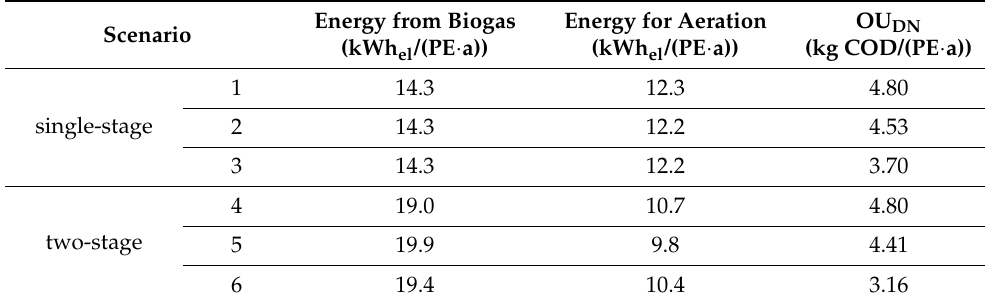
Table 4. Energy for aeration, energy from biogas utilisation, and OU DN for TN removal of 80% in single-stage and two-stage WWTPs with different SDE treatment